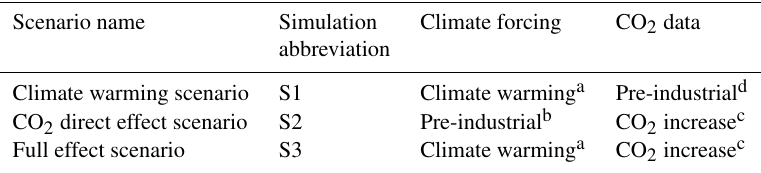
Table 1. Summary of scenarios and forcing